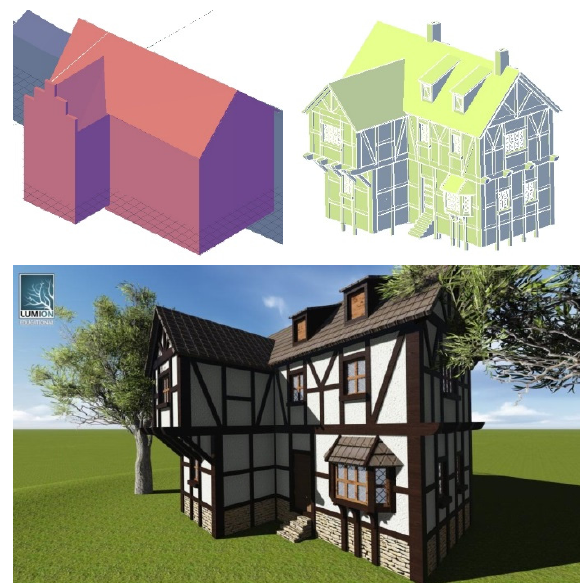
Figure 6. Development of a building in the outer ward: Initial CAD model (top left), detailed model (top right), textured model in Lumion 3D (bottom)